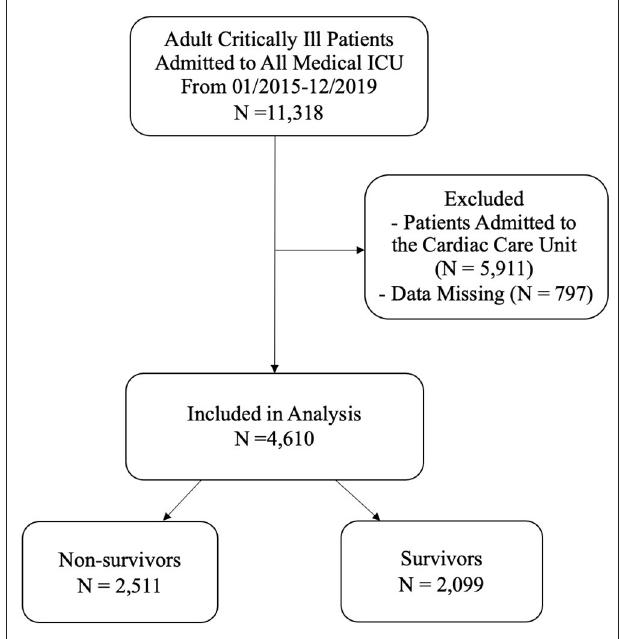
FIGURE 1 | Flowchart of enrollment of subjects eligible for analyses. ICU, intensive care